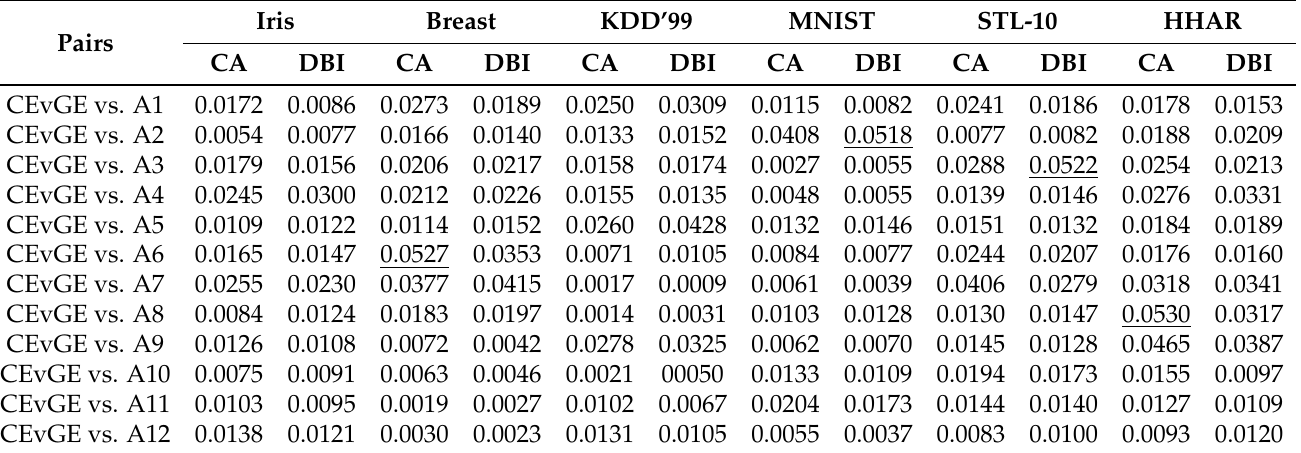
Table 8. The p -values of Student’s t -test of CEvGE vs. contrastive algorithms on real data sets ( p > 0.05 are